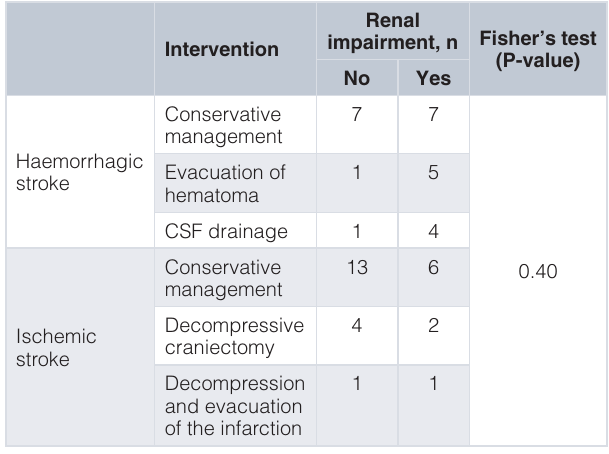
Table 4. Crosstablulation of haemorrhagic and ischemic stroke patients with and without renal impairment according to intervention.